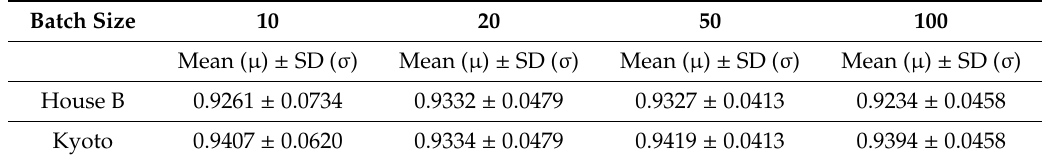
Table 5. Mean & standard deviation of variable range Batch Size on 10,000 epochs.